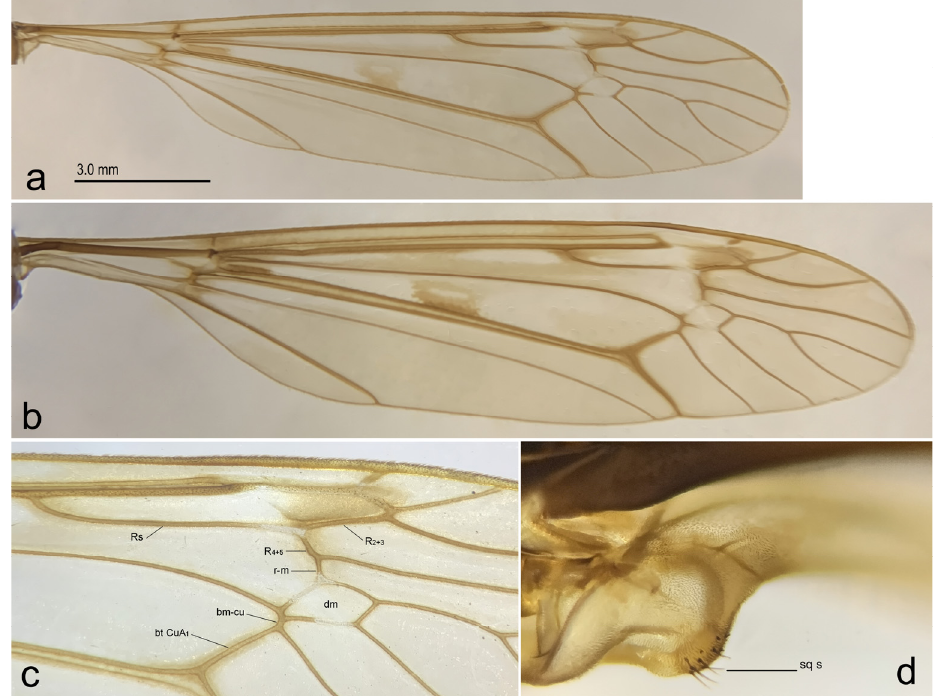
Figure 8. Zelandotipula gelhausi sp. nov.; ( a ) Right wing, holotype male; ( b ) idem , paratype female; ( c ) Detail of wing venation, holotype male; ( d ) Setae on squama.